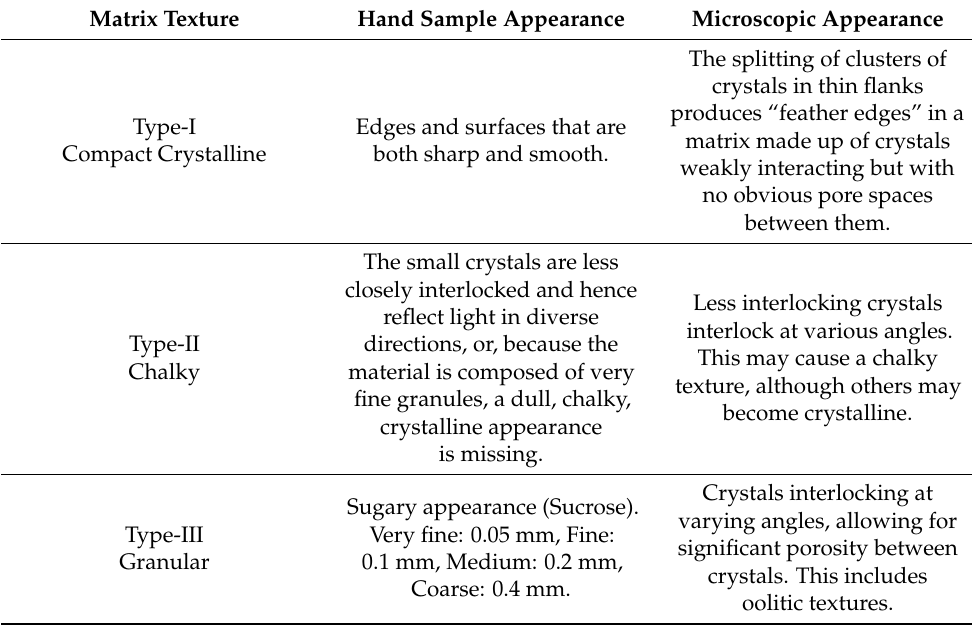
Table 1. Micrite texture Archie classification of carbonate rock.